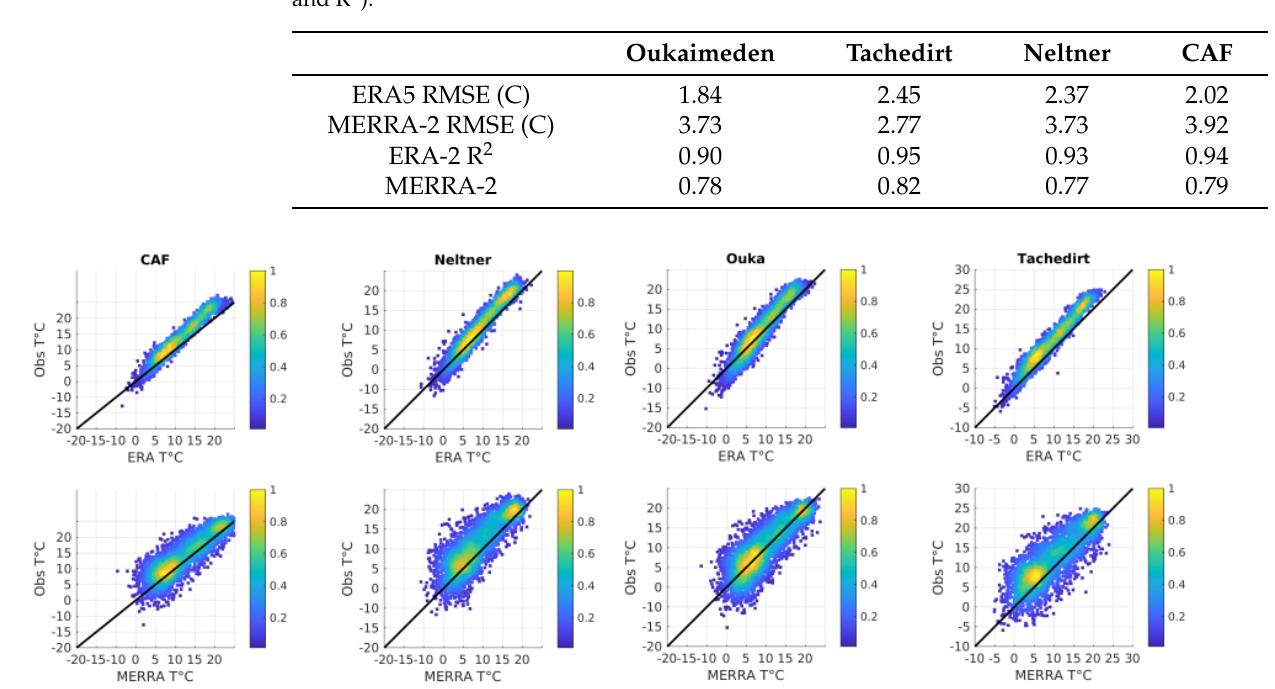
Figure 7. Observed air temperature from AWS (left) versus modeled air temperature at the same location (right). Upper figures represent ERA5 comparison and